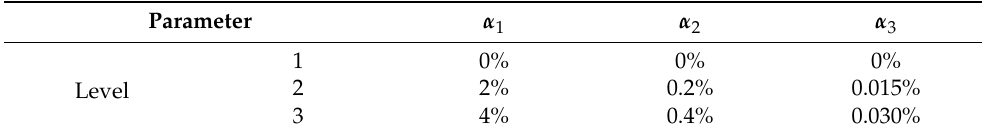
Table 6. Parameter levels.